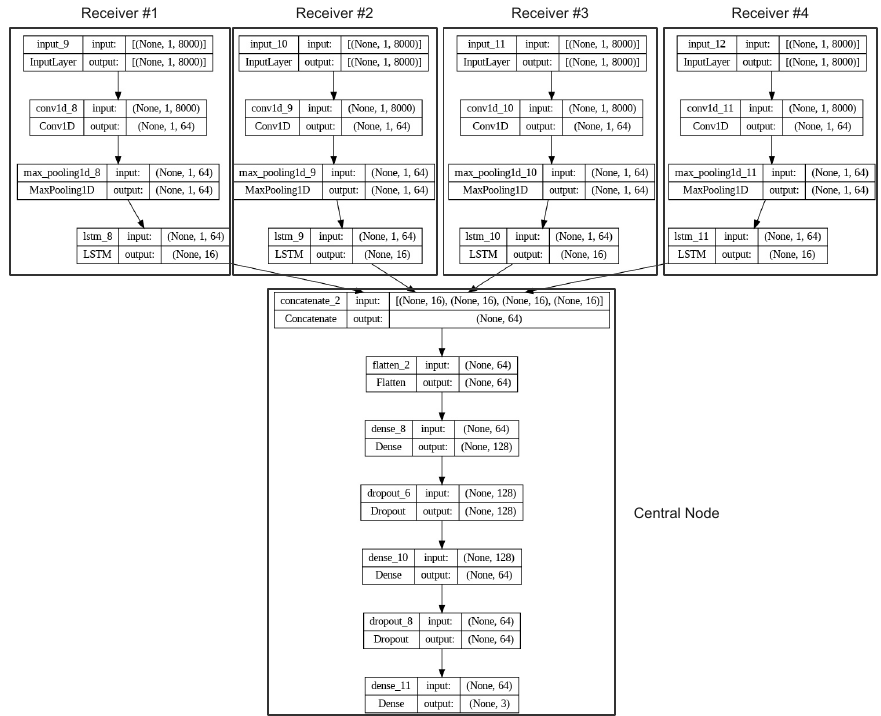
Figure 12. RadarNET: a neural network employed for filtration, compression, and delay estimation that utilizes a unique structure. The input node is duplicated and distributed to all four receiving antennas, ensuring that each antenna node has the same network structure and coefficient val- ues. This allows for efficient and consistent processing of incoming signals, ensuring accurate and reliable